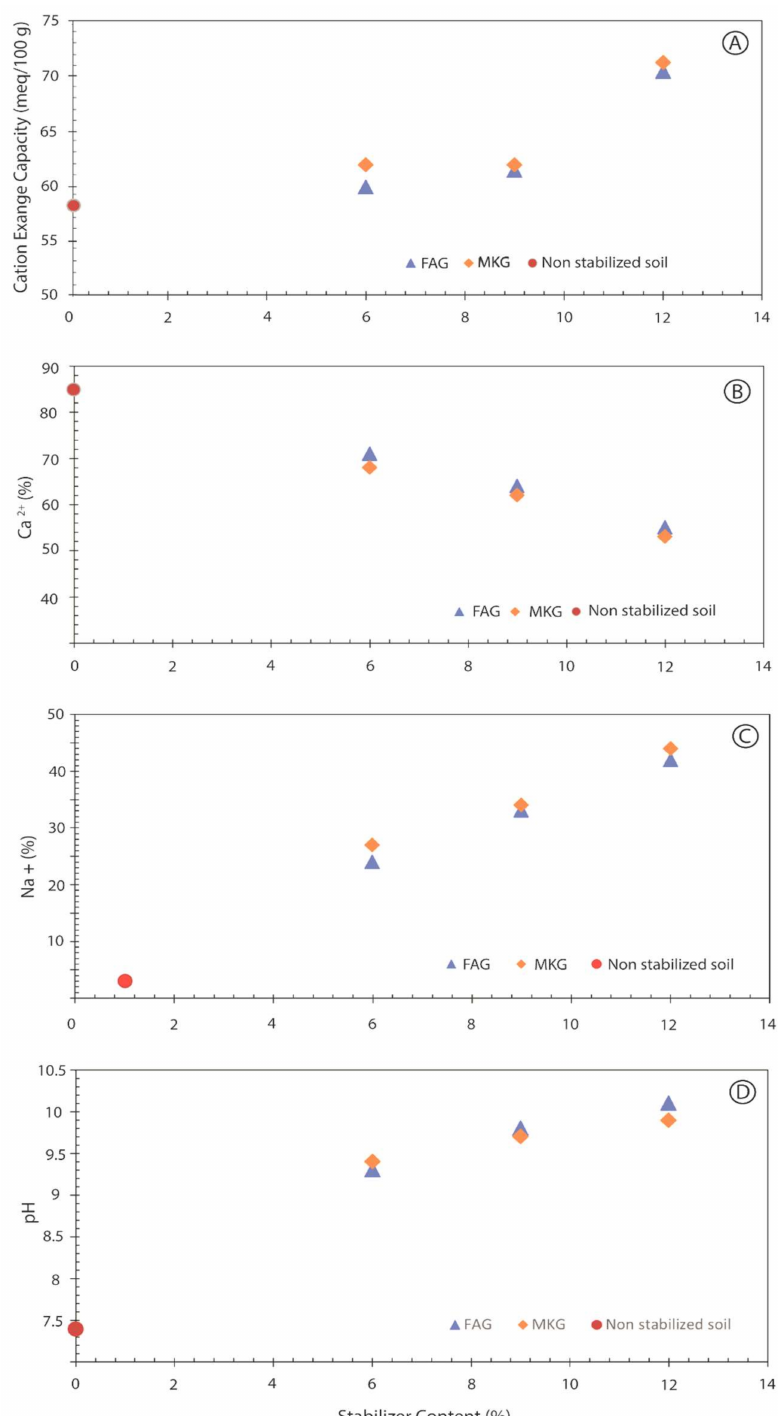
Figure 2. Cation exchange capacity test results: ( a ) Cation exchange capacity versus different stabilizer content, ( b ) Change in Ca 2+ percentage with different stabilizer content, ( c ) Change in Na + percentage with different stabilizer content, and ( d ) Change in pH with different stabilizer